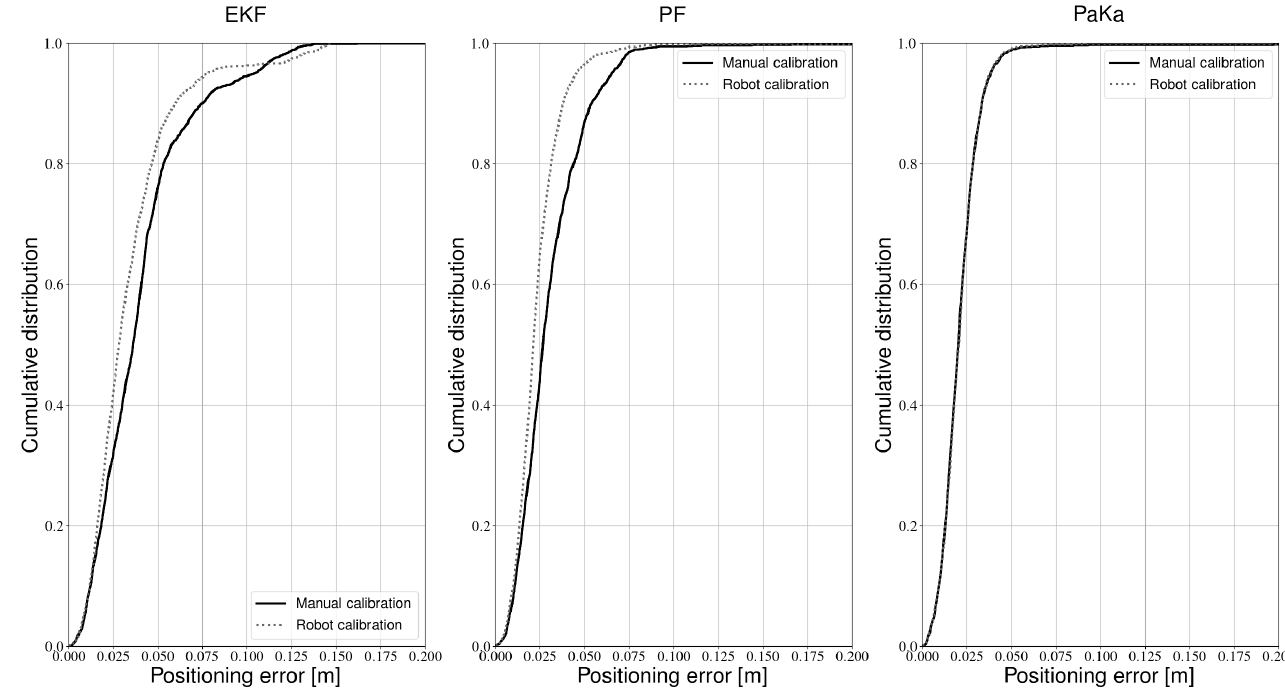
Figure 15. Cumulative positioning error distributions of calibration methods for different